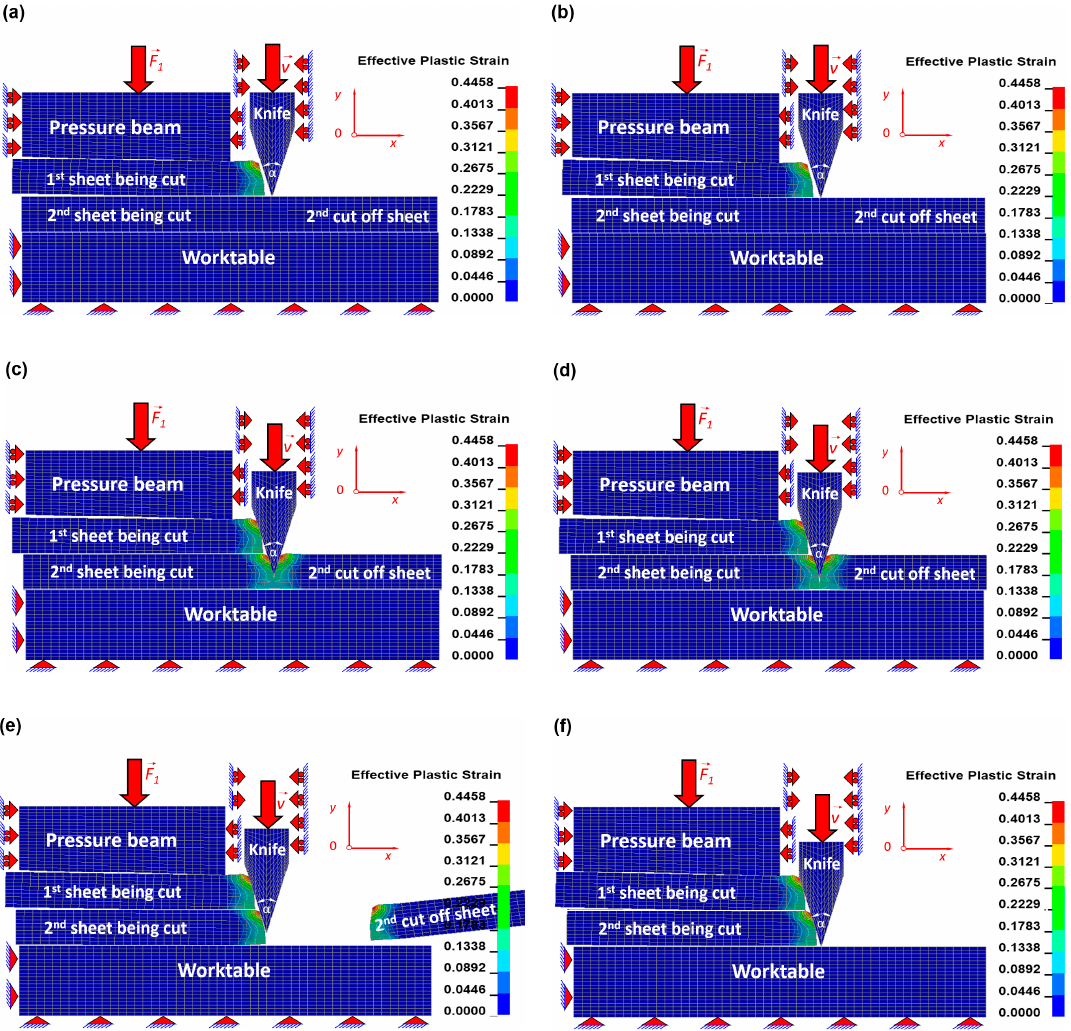
Figure A2. Contour maps of equivalent Huber–Mises plastic strain (mm/mm) in the bottom sheet in a bundle being cut for the chosen time instants (ms): ( a ) t = 12.04, ( b ) t = 12.07, ( c ) t = 18.00, ( d ) t = 18.35, ( e ) t = 18.43, ( f ) t = 22.00.